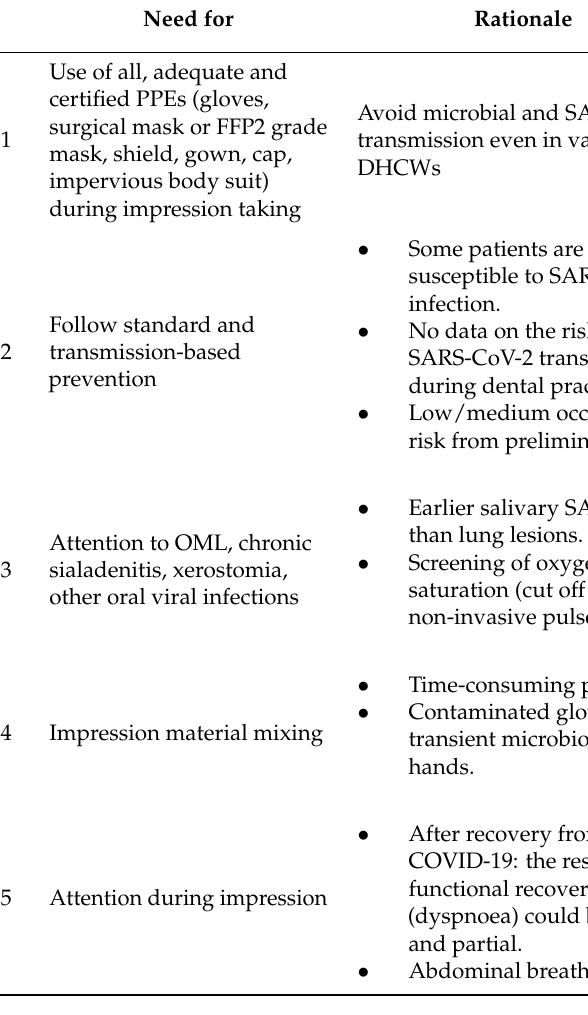
Traditional CAD/CAM Technology Technology